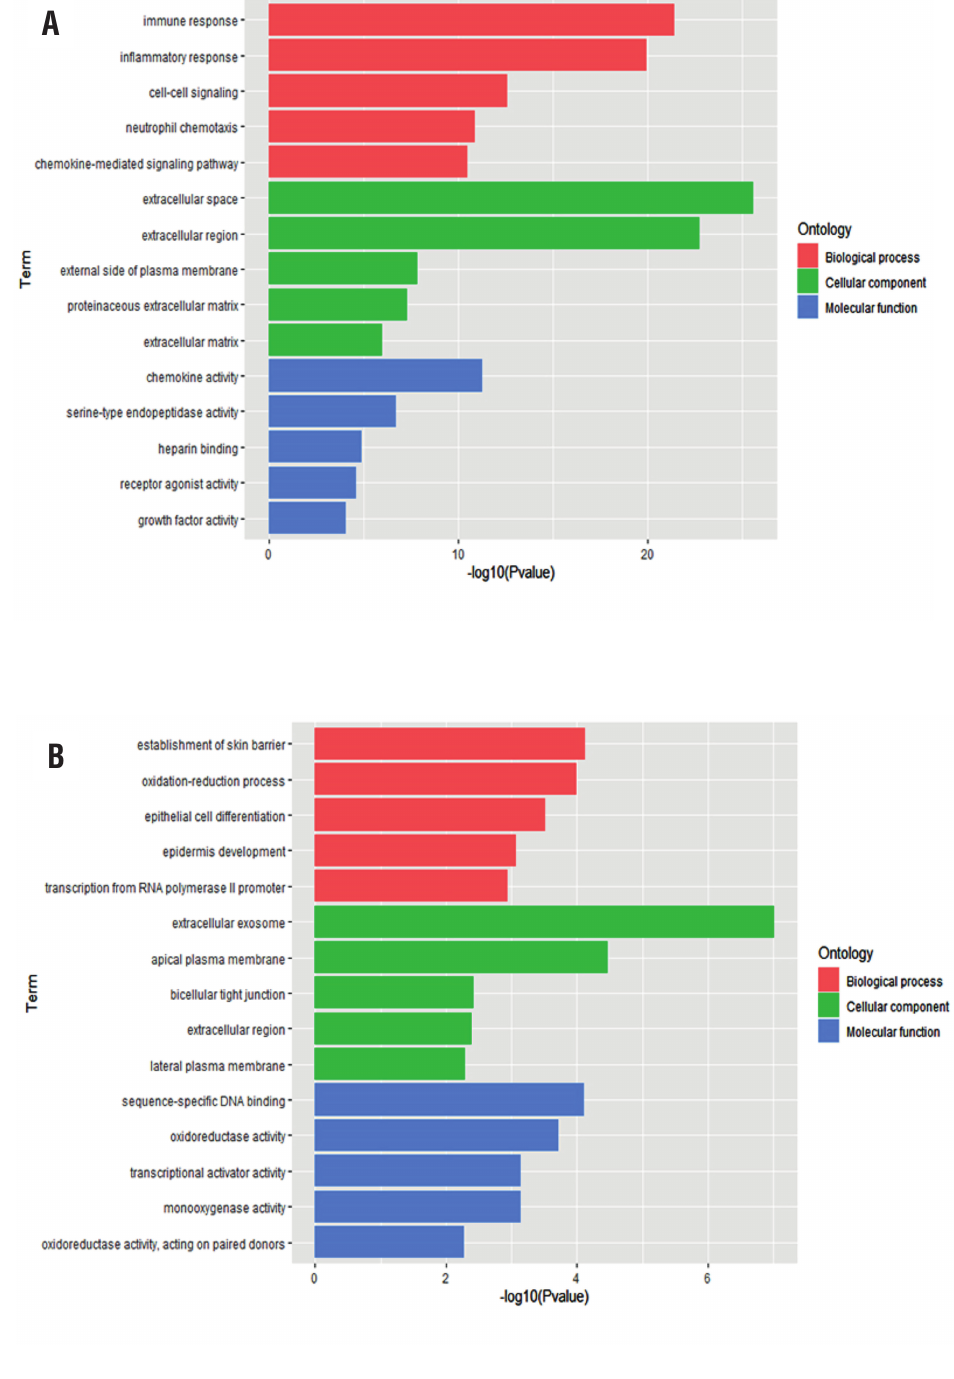
Figure 3 - (a) The first five Gene Ontology (GO) enrichment analyses for up-regulated DEGs. (b) The first five GO enrichment analyses for down-regulated DEGs. The Kyoto Encyclopedia of Genes and Genomes (KEGG) pathway analysis of up-regulated (c) and down-regulated genes